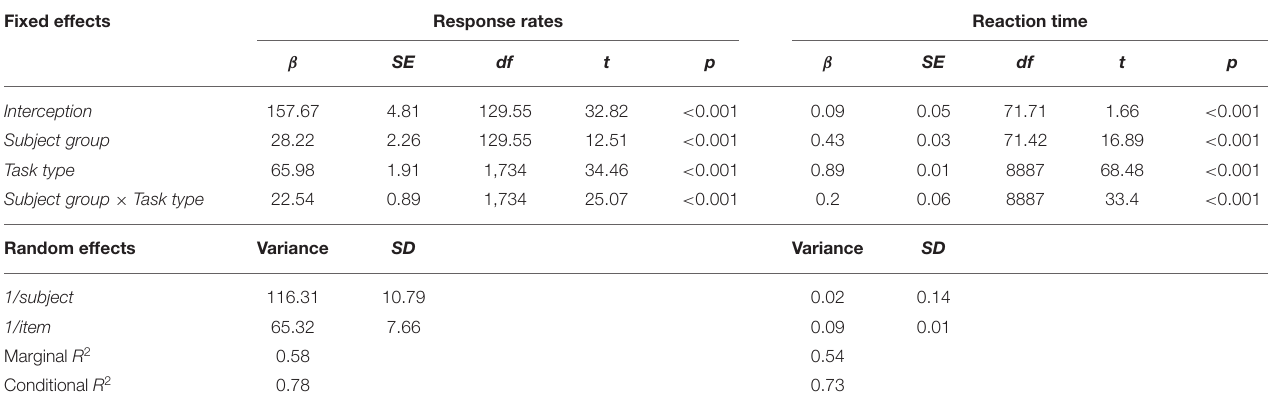
TABLE 3 | The results of LMM for response rates and reaction